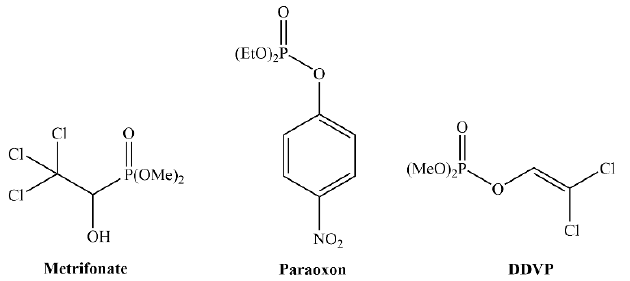
Figure 1. Structures of some organophosphorus-based serine esterase inhibitors.